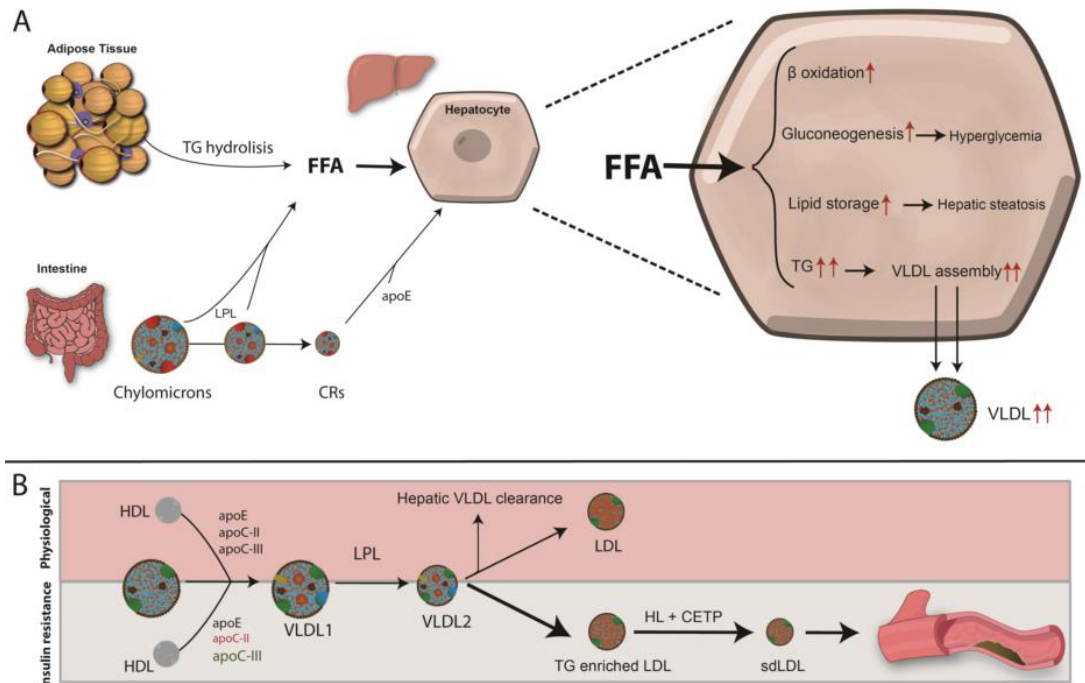
Figure 7. Diabetic dyslipidemia: mechanisms leading to T2DM dyslipidemia and lipoprotein clearance in physiological an IR conditions. ( A ) IR leads to an impaired adipose tissue fat storage, resulting in constitutive FFA release from the intracellular TG stores of adipocytes. The released FFAs are taken up by hepatocytes, where they can be directed to the mitochondria and undergo β -oxidation; be re-assimilated into TG to assemble new VLDL particles; shifted to gluconeogenesis resulting in a worsening of hyperglycemia; or stored as TG leading to hepatic steatosis. ( B ) Under physiological conditions, VLDL particles incorporate apo-CII and apoE from HDL allowing VLDL to be progressively lipolyzed leading to the generation of smaller VLDL particles (upper panel). T2DM and IR impair metabolism and clearance of chylomicrons and VLDLs. Activation of CETP promotes an exchange of TG out of RLPs and incorporates CE from HDL and LDL particles leading to reduced levels of circulating HDL-C and an increase in the more atherogenic sdLDL particles (lower panel). TG: triglyceride; FFA: free fatty acid, LPL: lipoprotein Lipase; CR: chylomicron remnants; HL: hepatic lipase; CETP: Cholesteryl Ester Transfer Protein; ApoE: apolopoprotein E; ApoC-II: apolipoprotein CII; apoC-III: apolipoprotein CIII; VLDL: very low-density lipoprotein; sdLDL: small dense